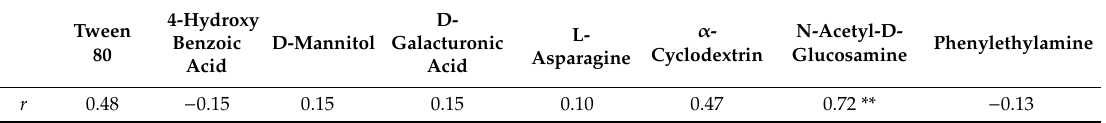
Table 2. Interrelation between SIR and BIOLOG data on 8 substrates. ** correlation significant for p < 0.01.